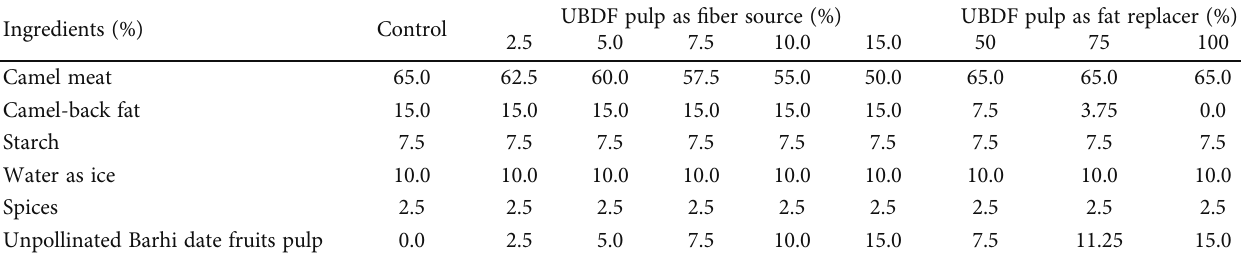
Table 1: Ingredients (%) of camel meat burger blends formulated with UBDF